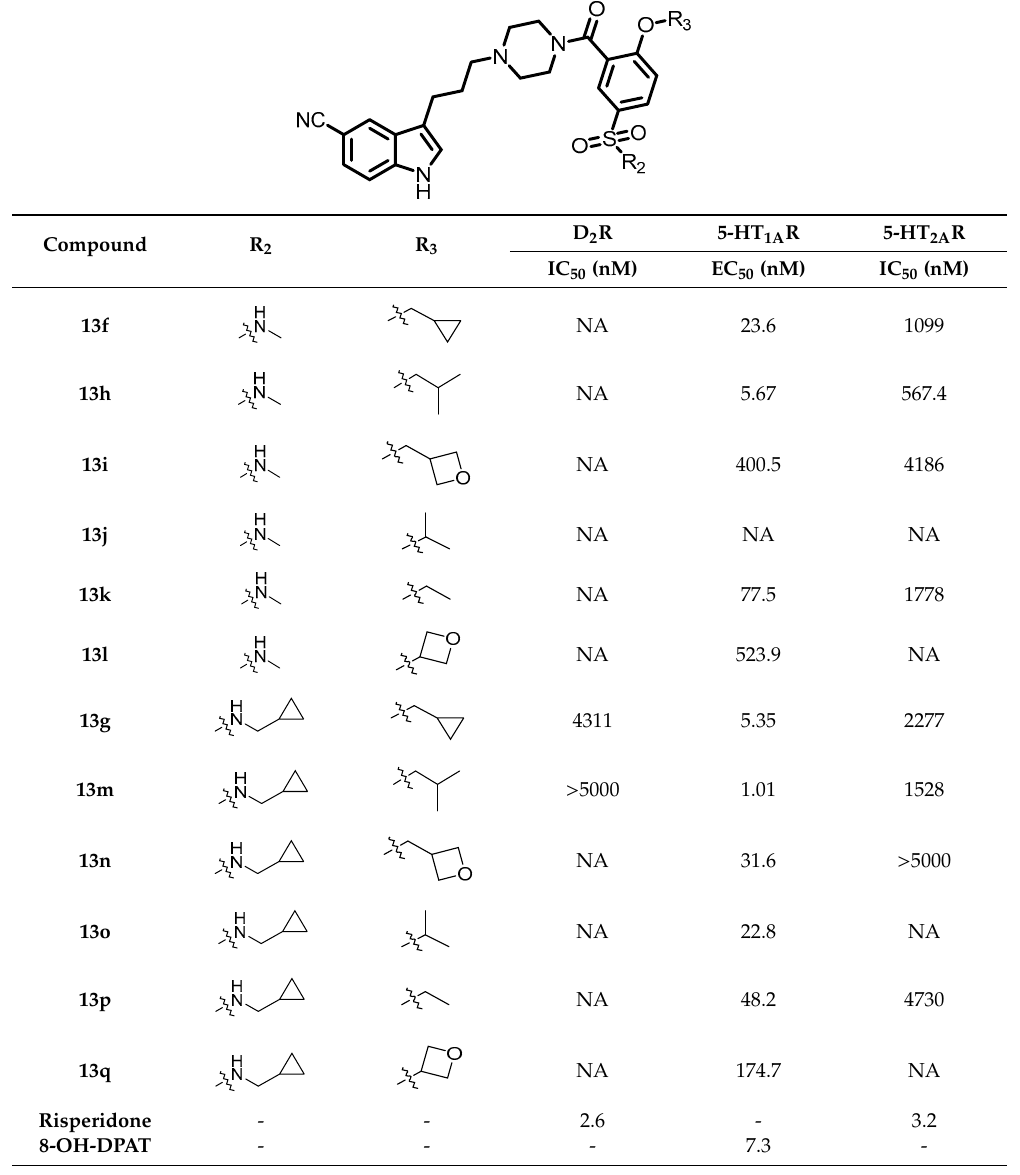
Table 2. Functional activities of compounds 13f – 13q for dopamine receptor (D 2 R) and serotonin receptors (5-HT 1A R and 5-HT 2A R).